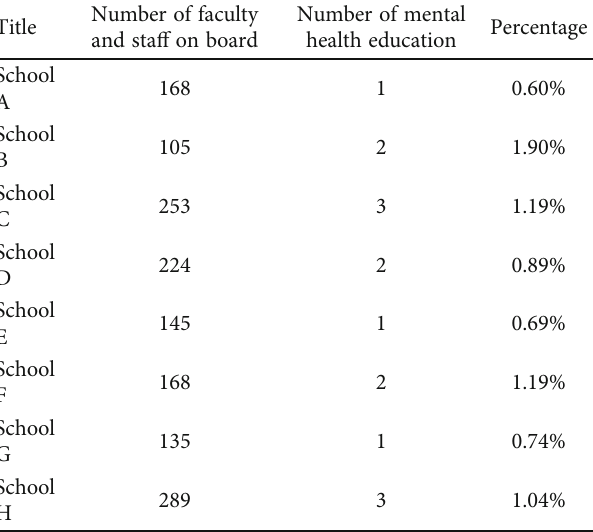
Table 1: Basic information of teachers in the selected schools. Number of faculty Title and sta ff on